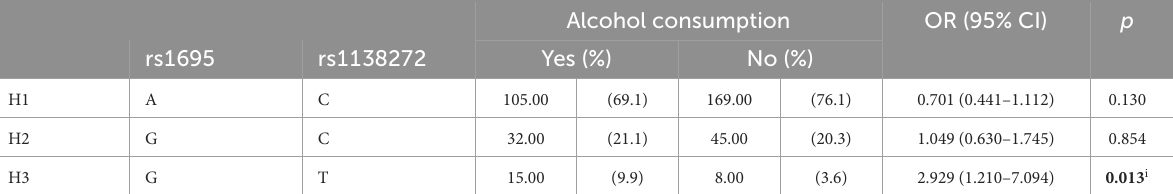
TABLE 9 Haplotype association analysis of the GSTP1 rs1138272 and rs1695 variants with alcohol as migraine